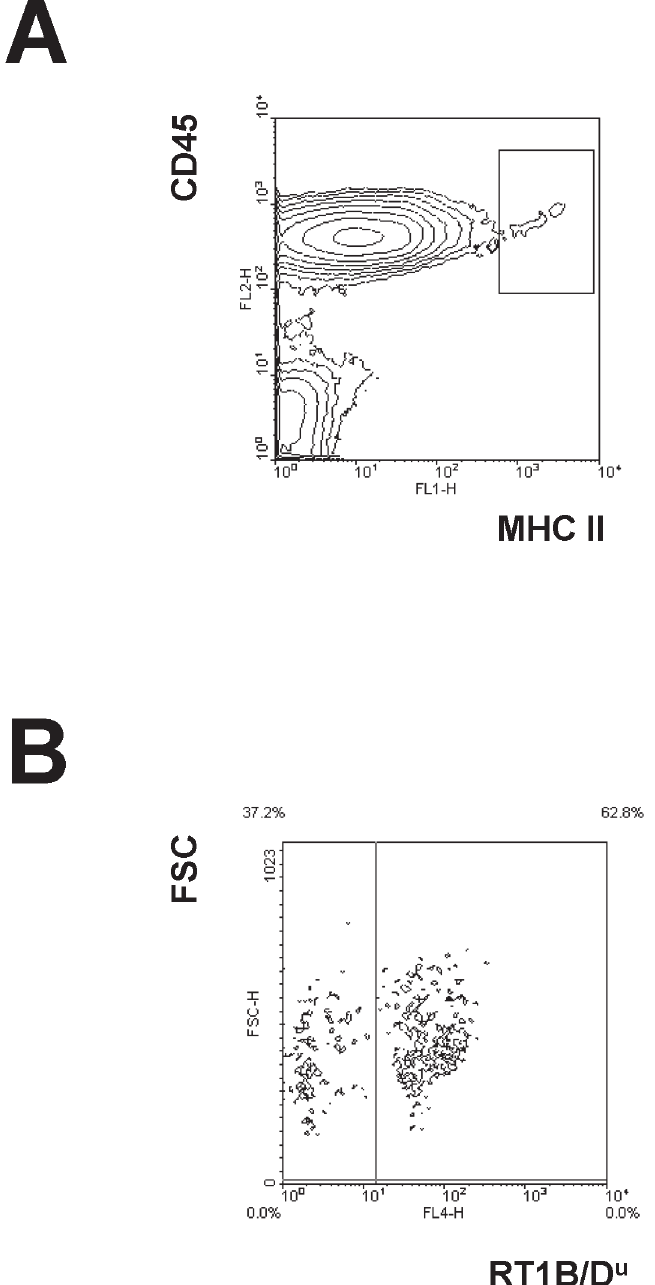
Fig 1. Detection of donor-derived MHC class II high cells. Three colour flow cytometry was used to detect highly expressing MHC class II donor cells of BMT recipients. Mononuclear cells were pre-gated concerning scatter properties. ( A ) Leukocytes expressing high density of MHC class II antigens were gated using anti- CD45 mAb (OX-1) and anti-MHC class II mAb (OX-6). ( B ) Anti-RT1B/D u mAb (1H1A) was used to detect cells of donor origin (1H1A + ). Data from a representative chimeric recipient treated with 6 Gy and Srl for 28 days are shown.